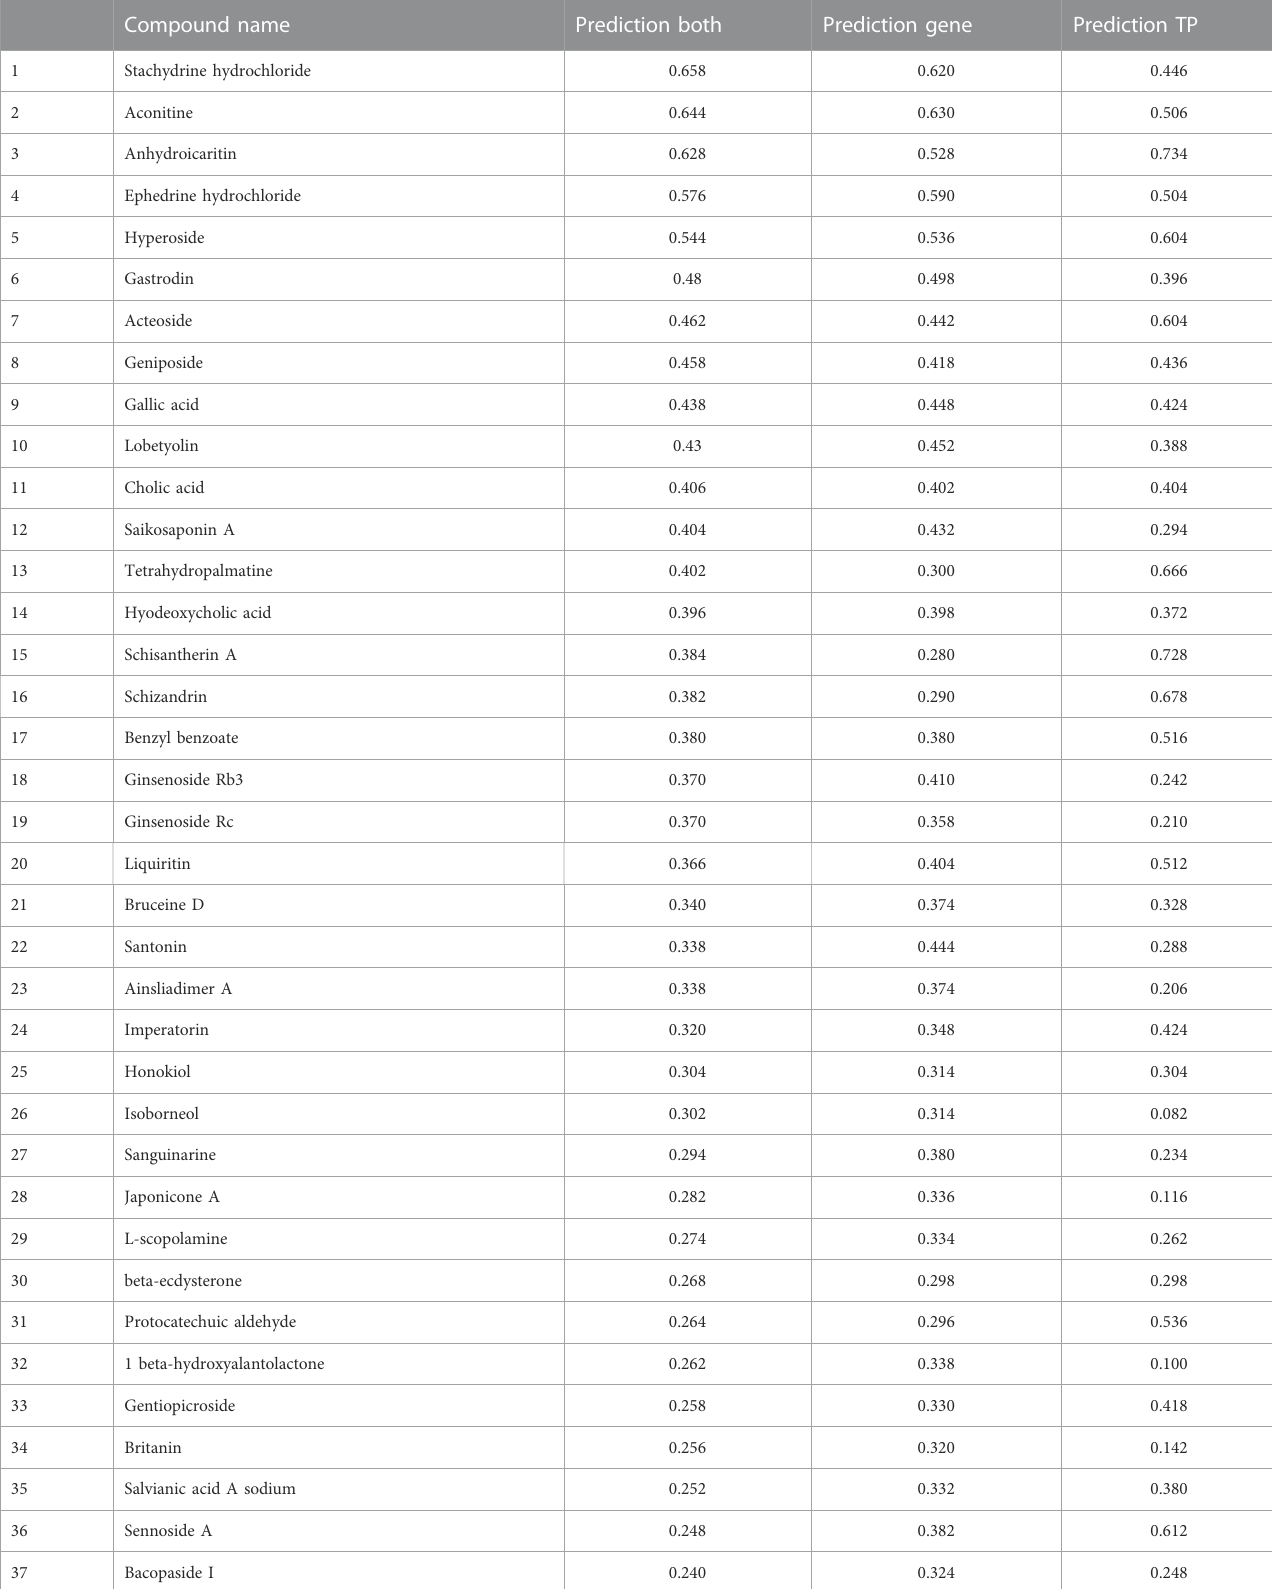
TABLE 2 Prediction results of 49 individual “ unknown metabolites ” ranking their probability of being pro-angiogenic or anti-angiogenic by Machine Learning developed in the current study. Prediction Gene means predicted by gene expression; Prediction TP means predicted by PIDGIN targets; Prediction Both